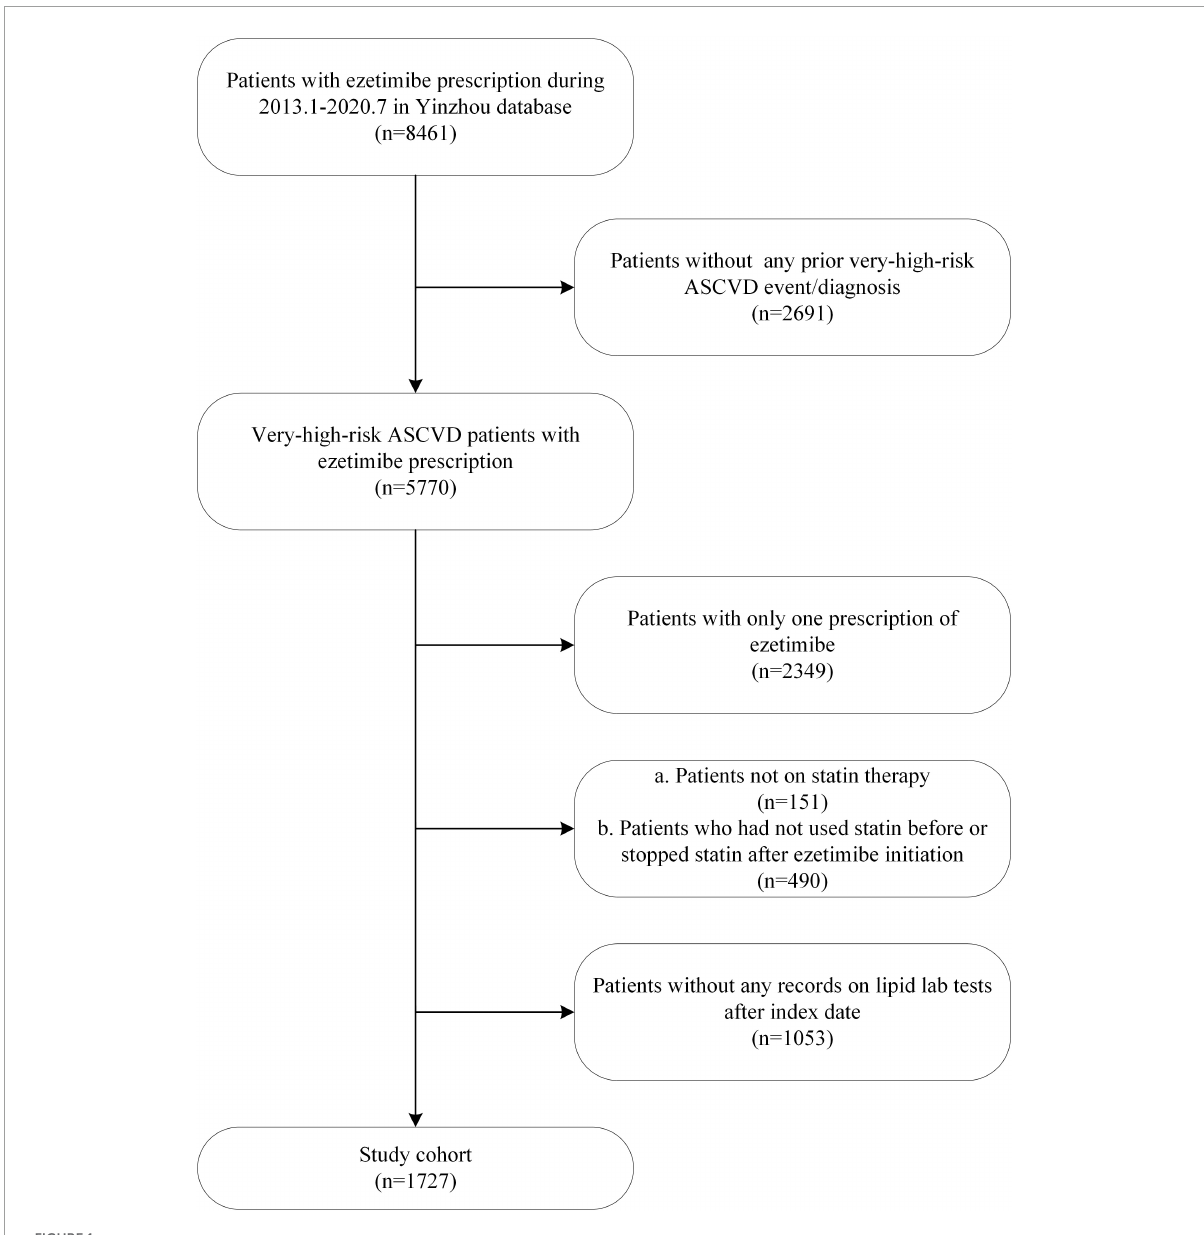
FIGURE1 Flowchart of cohort selection.